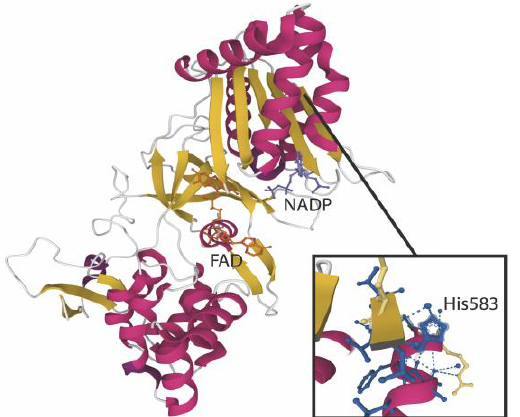
Figure 6. Pazopanib aldehyde interaction with NADPH-cytochrome P450 oxidoreductase. The structure of the POR enzyme (PDB reference: 3QFS [17]) is depicted here with the major cofactors NADP and FAD. The enlarged view focuses on His583 modified by P-CHO after incubation with microsomes.